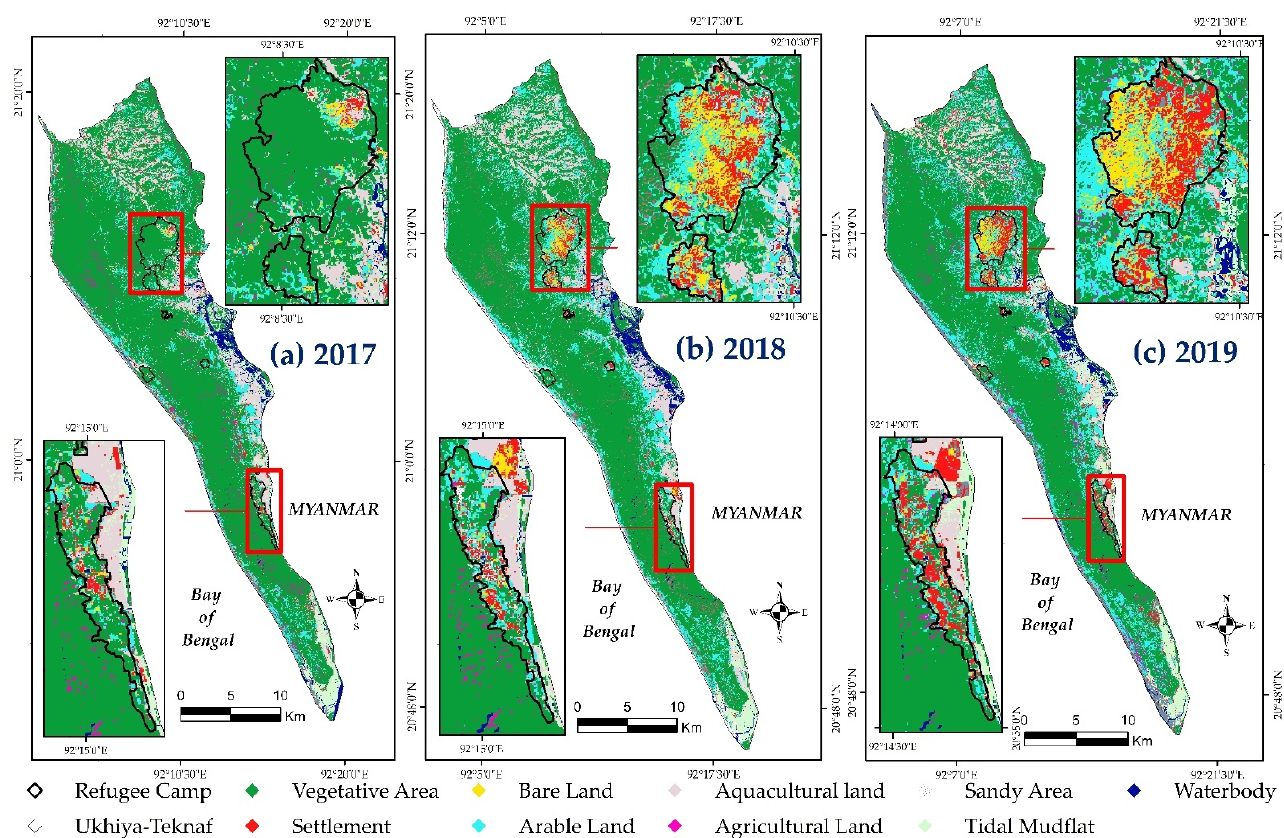
Figure 5. Land cover maps for the study area, Ukhiya-Teknaf region, classified into nine major land cover classes including: vegetation (green), bare land (yellow), agricultural land (light blue), sandy area (grey), water-body (dark blue), settlement (red), arable land (cyan), agricultural land (violet), and tidal mudflat, at three time-steps ( a ) 2017, ( b ) 2018, and ( c ) 2019.